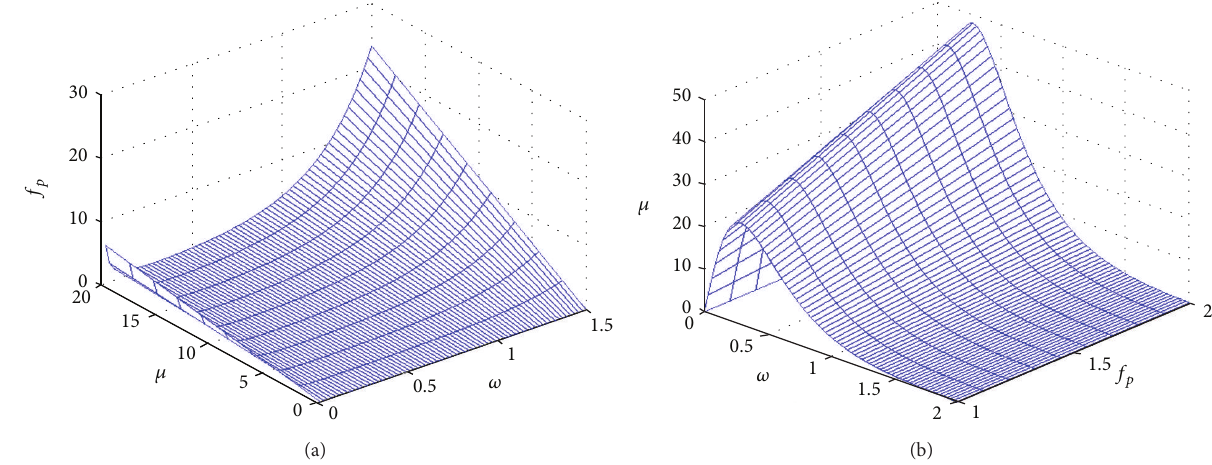
Figure 9: Homoclinic bifurcation curve for (a) control parameter 𝑓 𝑝 and (b) control parameter 𝜇